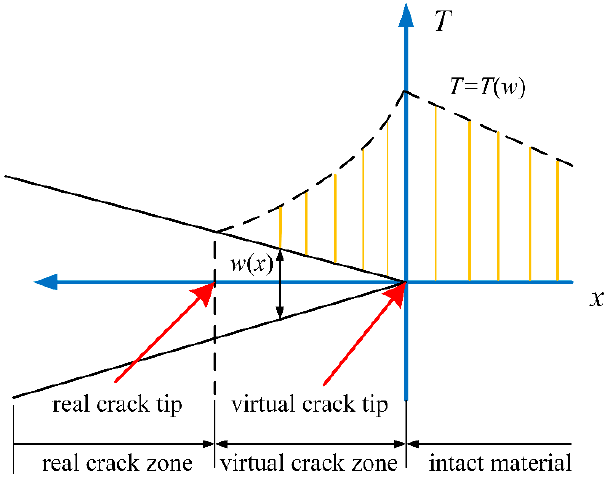
Figure 1. Cohesive zone model.